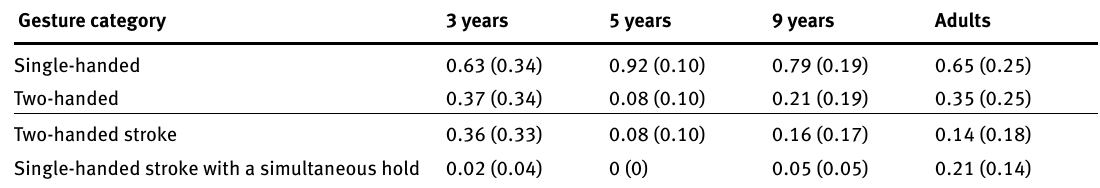
Table 2. The mean proportion and the standard deviations (in parentheses) of each hand use category in representational gesture